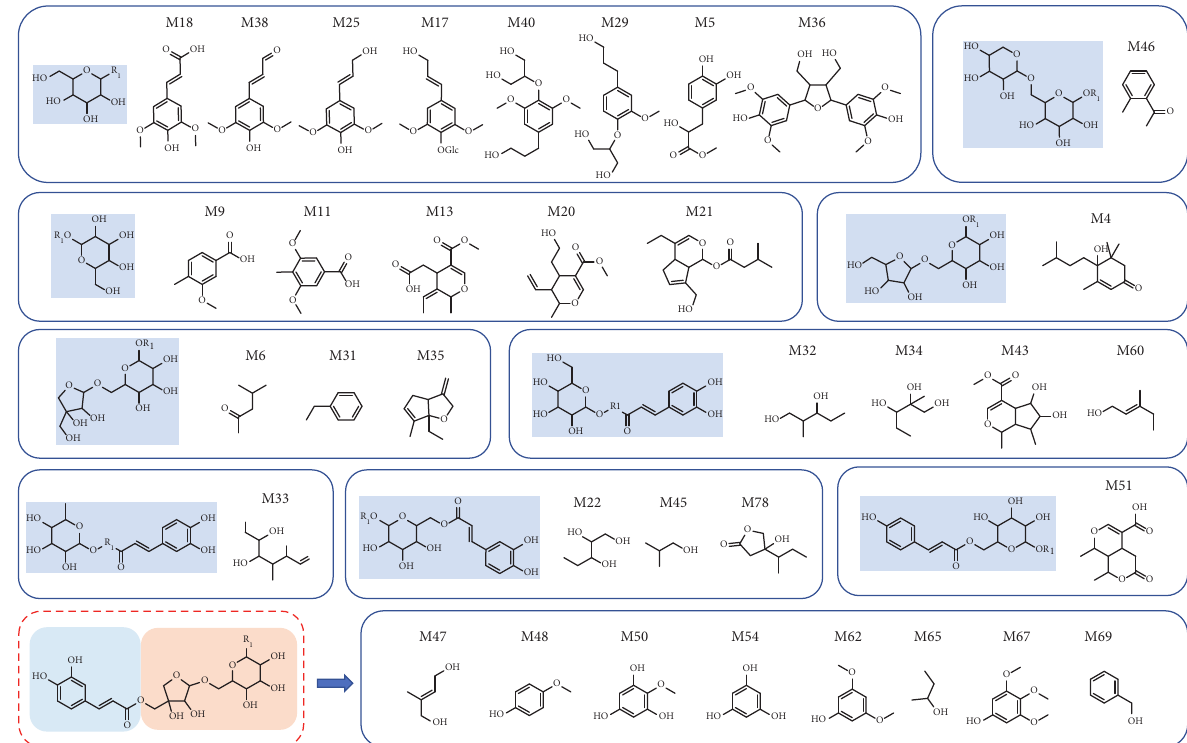
Figure 7: Representative glycoside structures. Glycosides are formed when a class of nonsugar compounds is combined with a